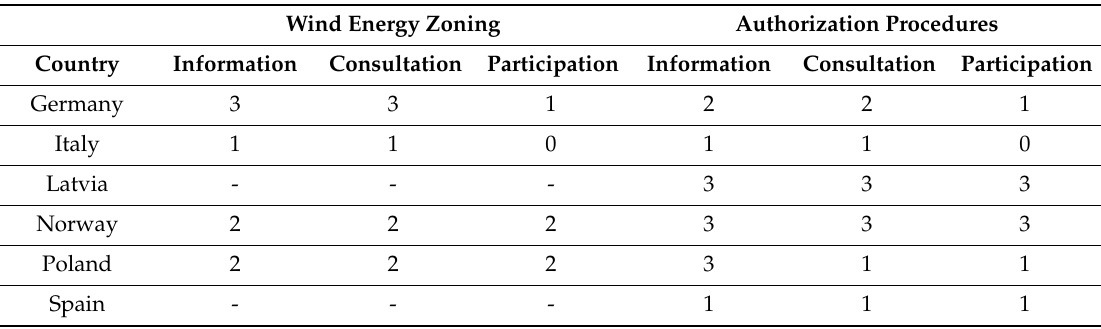
Table 2. Comparative analysis of di ff erent measures for public engagement levels (Information, Consultation, Participation) in decision making procedures (zoning and